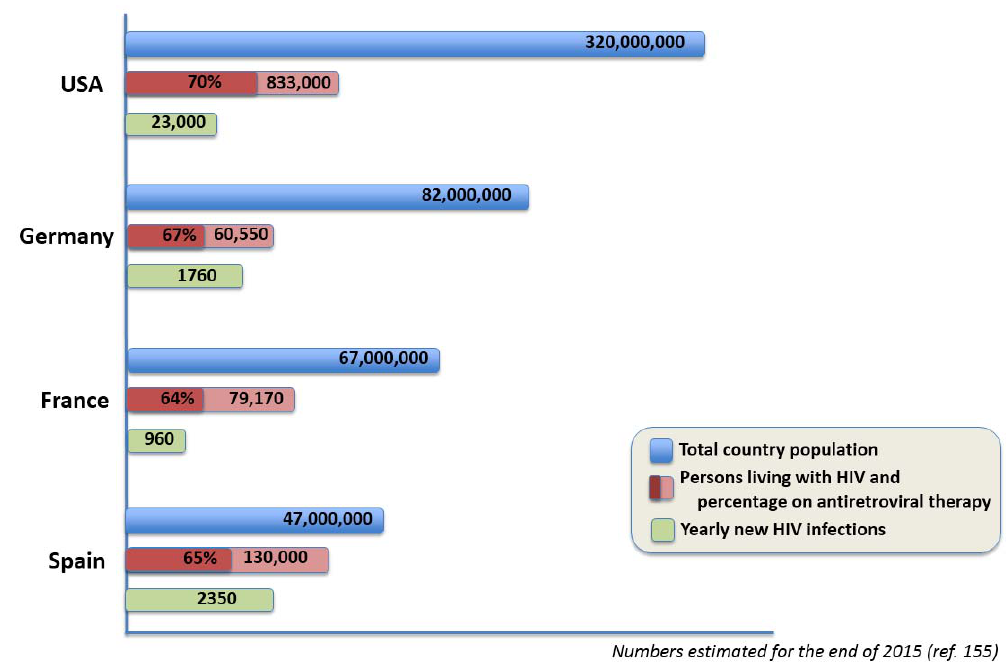
Figure 6. Burden of HIV infection in Spain. Comparison with other Western countries.